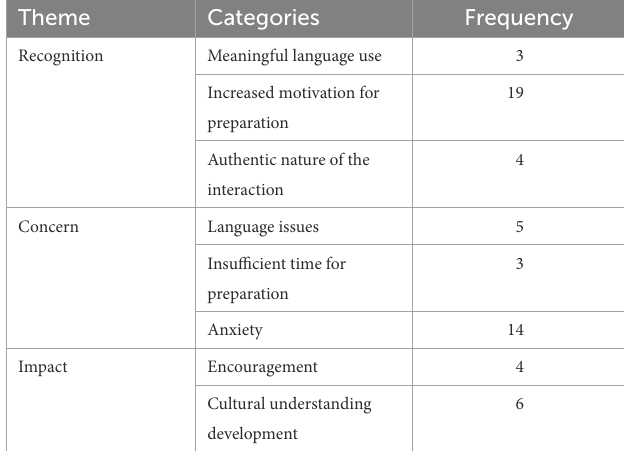
TABLE 1 Attitude towards the intercultural videoconferencing presentation activity.